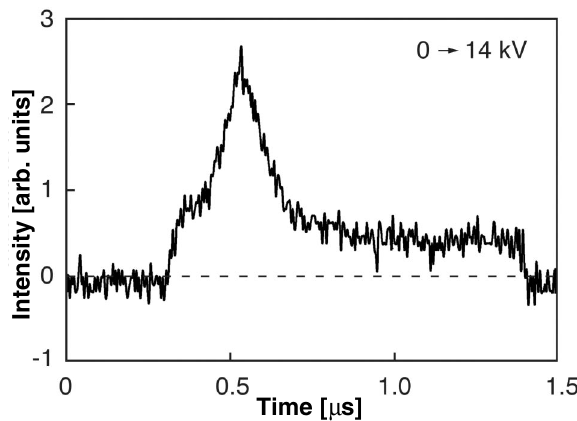
FIG. 3. Beam profile after nonlinear compression by means of an rf voltage jump from 0 to 14 kV and an appropriate extraction kicker timing.